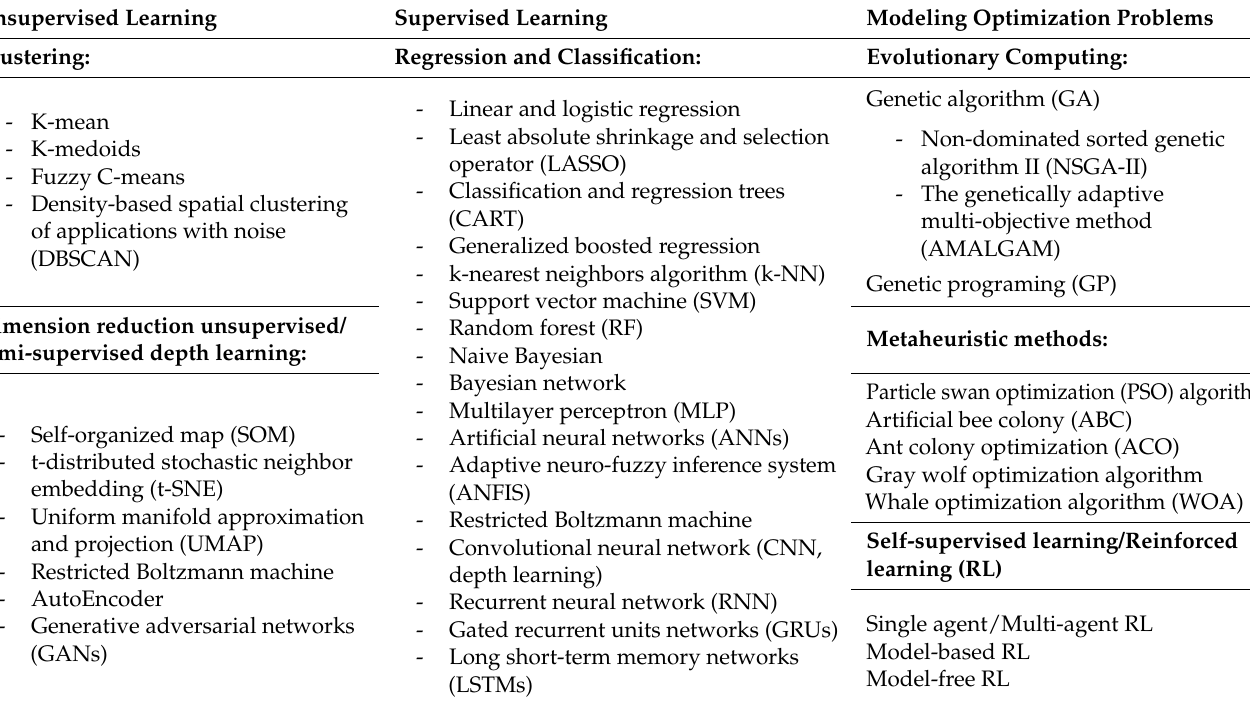
Table 1. General classification of geospatial artificial intelligence (GeoAI) and machine learning